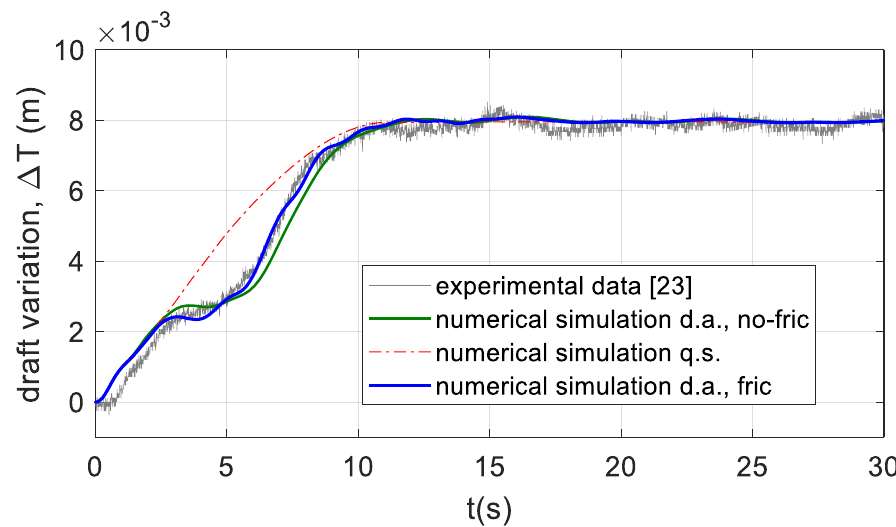
Figure 6. Transient flooding draft of the damaged barge: experimental vs. numerical results (zero is the initial draft).